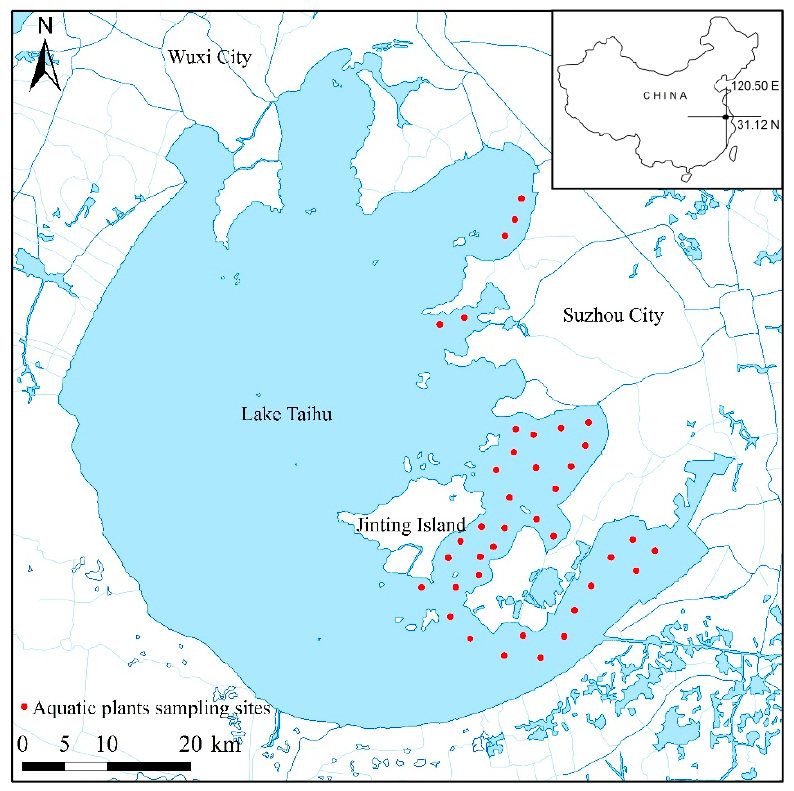
Figure 1. Aquatic plants sampling sites.